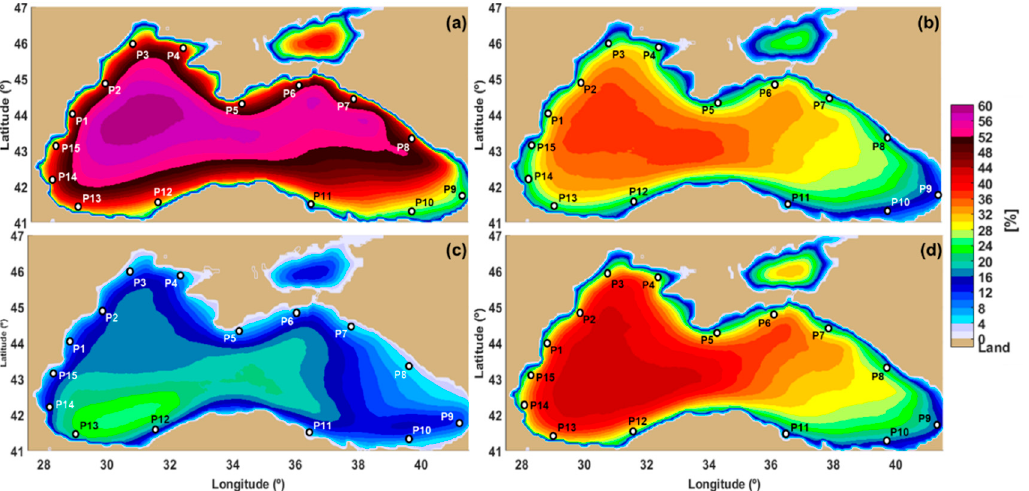
Figure 3. Seasonal distribution of the Hs parameter higher than 1 m considering the entire 30-year SWAN simulations (1987–2016), where: ( a ) winter; ( b ) spring; ( c ) summer; ( d ) autumn.